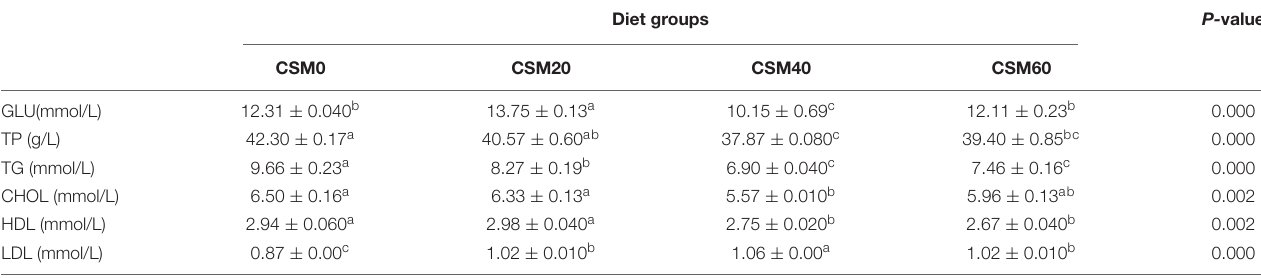
TABLE 5 | Plasma biochemical index of golden pompano fed different experimental diets for 6 weeks. Diet groups P-